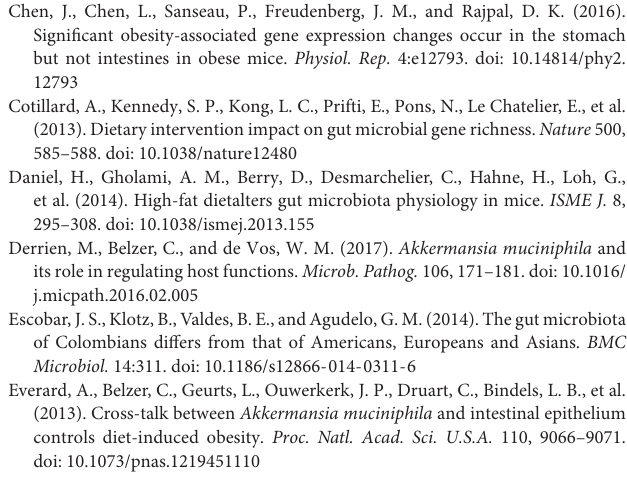
FIGURE S1 | Alpha diversity as revealed by Chao and Shannon index were reduced in 12HFD_G compared with 12CD_G (A,B) ( ∗ p < 0.05, ∗∗ p < 0.01), while no significant difference was observed between 12HFD_F and 12CD_F (C,D) . FIGURE S2 | Bacterial taxonomic profiling at the phylum level of gastrointestinal bacteria from different groups after 12 weeks. FIGURE S3 | Alpha diversity as revealed by numbers of observed operational taxonomic units (OTUs) was not significant between 12HFD_G and 24HFD_G (A) as well as 12HFD_F and 24HFD_F (B)